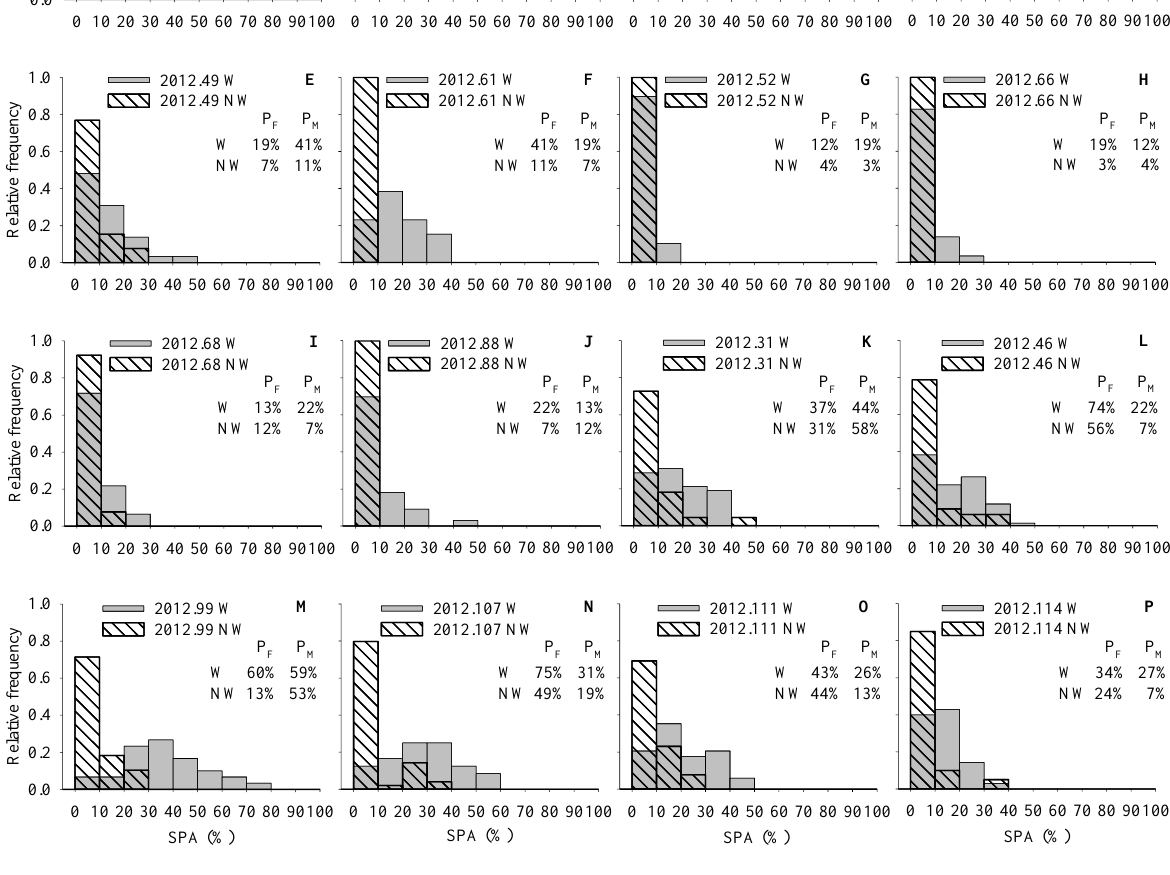
Figure 4. Relative frequency histograms of progeny of 16 families ( A – P ) classified by sporulation area (SPA) expressed as percentage of the fruit that was affected by the brown rot sporulation, on wounded (W) and non-wounded (NW) fruits. The mean values of female (P f ) and male (P m ) parents for each population are indicated. Embrapa Peach Breeding Program, 2015 – 2016, 2016 – 2017 and 2017 – 2018 growing seasons, Pelotas, Rio Grande do Sul, Brazil. Progeny: 2008.159 ( A ), 2009.38 ( B ), 2012.26 ( C ), 2012.43 ( D ), 2012.49 ( E ), 2012.61 ( F ), 2012.52 ( G ), 2012.66 ( H ), 2012.68 ( I ), 2012.88 ( J ), 2012.31 ( K ), 2012.46 ( L ), 2012.99 ( M ), 2012.107 ( N ), 2012.111 ( O ) and 2012.114 ( P ). The maternal effect was analyzed (the contrast between the F1 progeny versus its reciprocal) for all the parameters (BRI, LD, LA, SPP, SPD, and SPA), and in all cases the differences were not significant ( p > 0.05) indicating that there is no maternal effect involved in the transmission of this trait. tween 30.1 – 51.7% on W fruits and between 25.0 – 40.5% on NW fruits. The h 2 estimates 41.6% for W fruits and between 18.7 – 33.9% for NW fruits (Table 2).